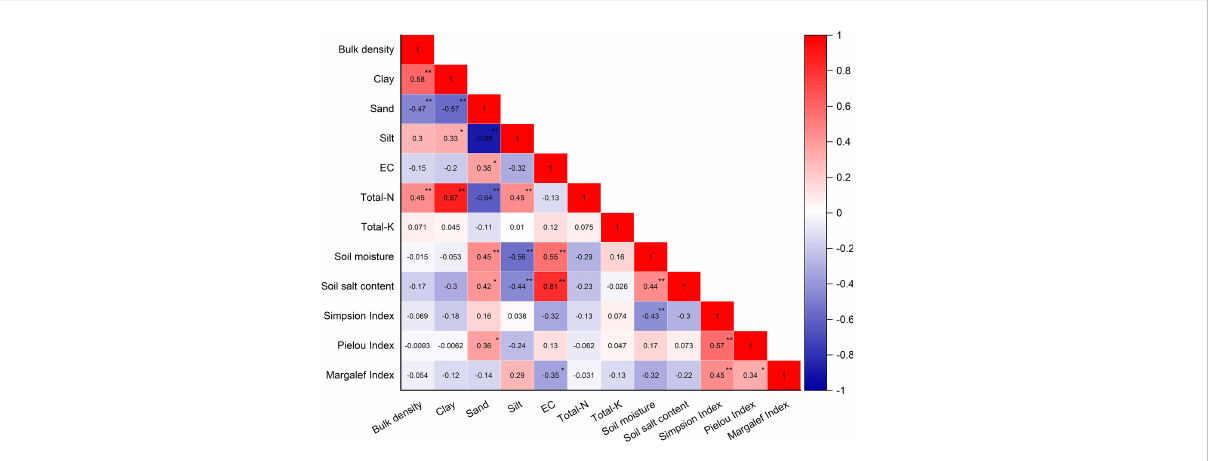
FIGURE 1 Correlation analysis of selected basic soil properties, soil moisture, soil salt content, and species diversity in Tamarix chinensis shrub plots. * indicate signi fi cant differences at P<0.05, and ** indicate signi fi cant differences at